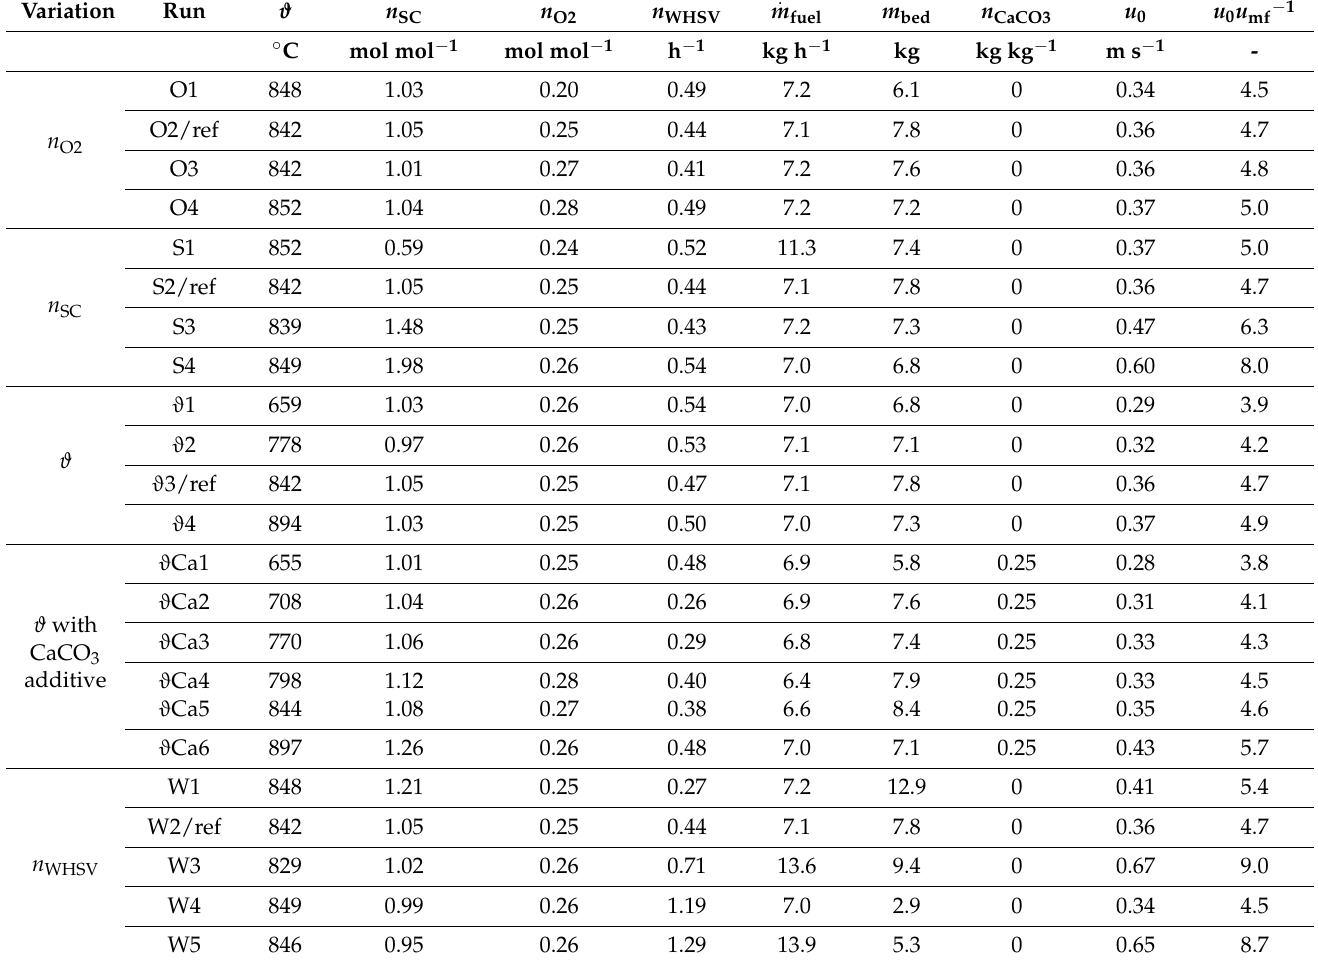
Table 4. List of all experimental of this work with respective operation